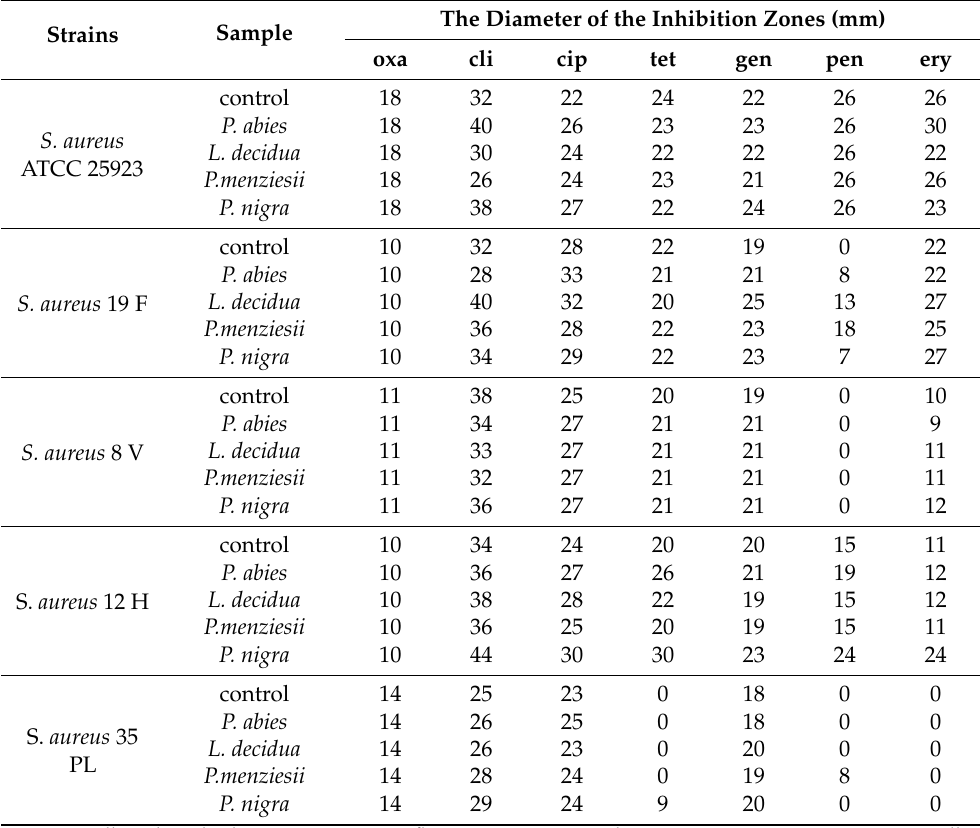
Table 3. The synergistic activity of the tested EOs with different